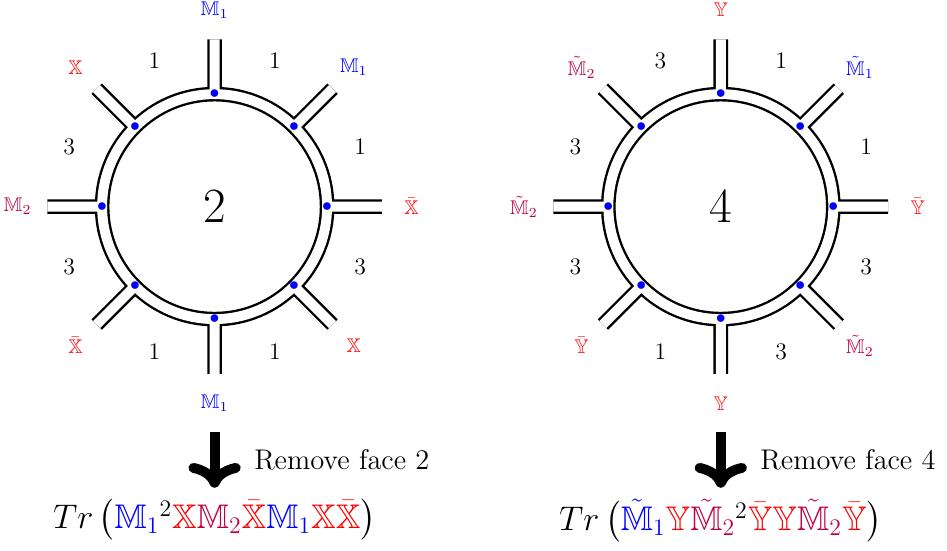
Figure 26 . Integrating-out faces 2 and 4 gives two e(cid:11)ective vertices, which under Wick contractions should encapsulate two faces: 1 and